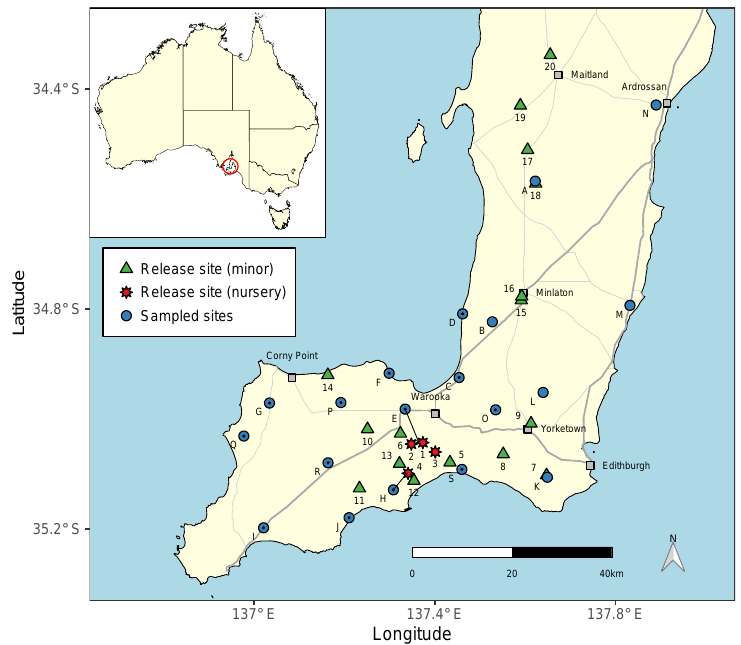
Figure 1. Geographic map of the Yorke Peninsula, South Australia, showing sites where S. villeneu- veana was released during 2000–2004 and locations sampled in 2019–2020. Multiple fly releases occurred at nursery sites (red stars) and single releases occurred at minor sites (green triangles). Sites where the fly was present (blue circles with a black dot) or not found (blue circles) are